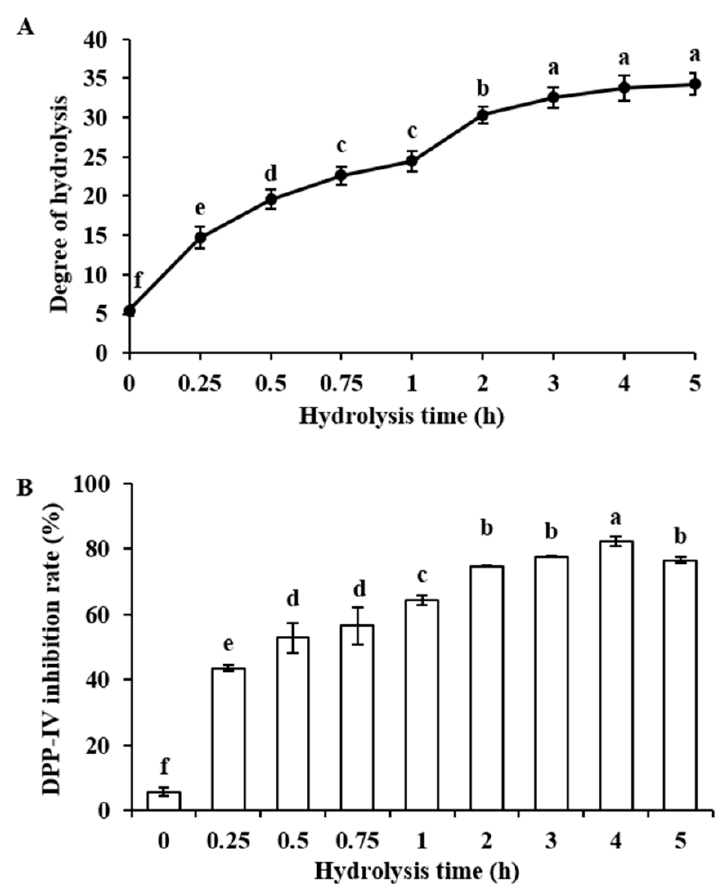
Figure 1. Degree of hydrolysis (DH) ( A ) and Dipeptidyl peptidase-IV (DPP-IV) inhibitory activity ( B ) of bovine α -lactalbumin hydrolysates. Bovine α -lactalbumin was hydrolyzed with alcalase (enzyme/substrate ratio = 5%, 0–5 h). The DPP-IV inhibition rate was measured using 1.0 mg/mL of hydrolysate (final assay concentration, protein basis). Values are expressed as means ± SD of 3 independent determinations. Different letters indicate significant differences ( p < 0.05).